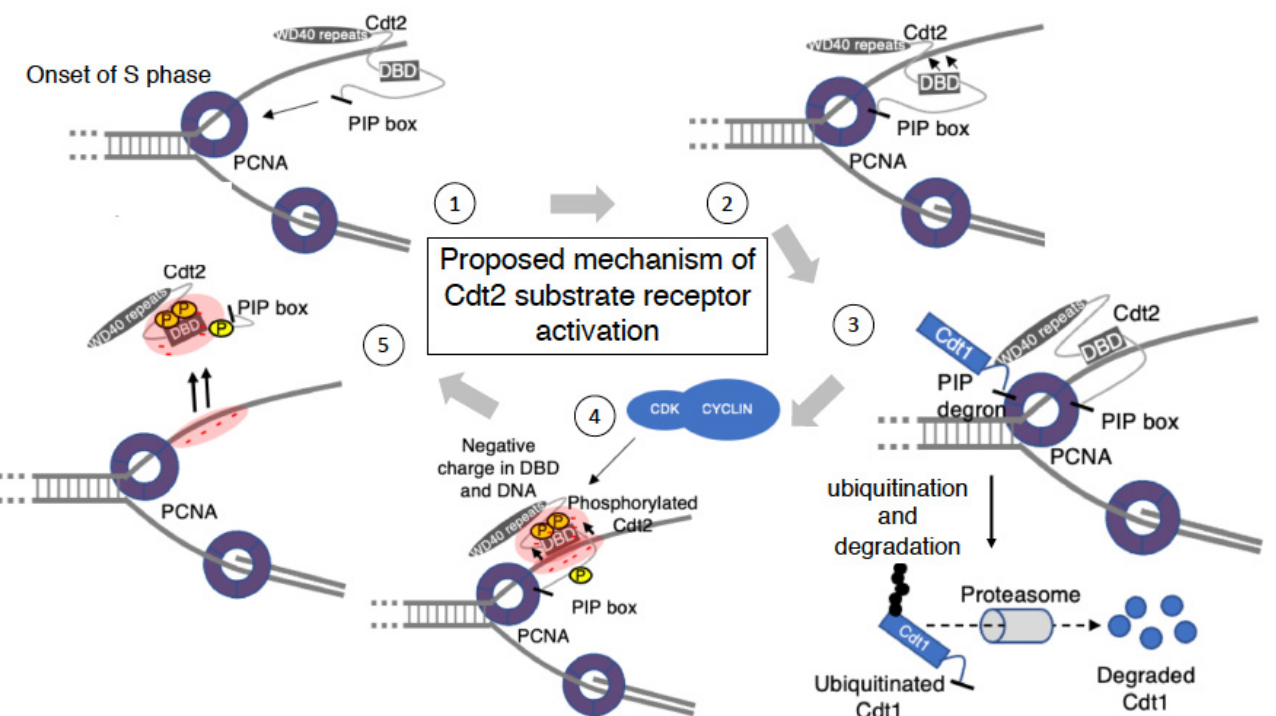
Figure 6. Proposed mechanism of Cdt2 substrate receptor activation ( 1 ). Interaction of Cdt2 with PCNA DNA , driven by the PIP box motif at the C-terminal end of Cdt2. ( 2 ). Interaction between the DNA binding domain (DBD) and single-stranded ssDNA to provide a stable and robust anchor for Cdt2 during substrate “catching”. ( 3 ). Recruitment of a substrate (Cdt1) independent of CRL4 Cdt2 through its PIP box. Cdt2 recognizes the PIP degron of Cdt1, as described in detail in sections 2 and 3, for ubiquitination and degradation by the proteasome. ( 4 ). Phosphorylation of Cdt2 by the CDK-Cylin complex at the end of S phase. The accumulation of negative charge from phosphate groups triggers electrostatic repulsion between Cdt2 and DNA and a reduction of PIP box affinity to PCNA DNA , which together lead to dissociation from PCNA, by an as yet unknown mechanism. ( 5 ). Detachment of phosphorylated Cdt2 from and its inability to bind to PCNA DNA , abrogating its ubiquitination activity. In the case of DNA damage, a similar process from step 1–3 is initiated.